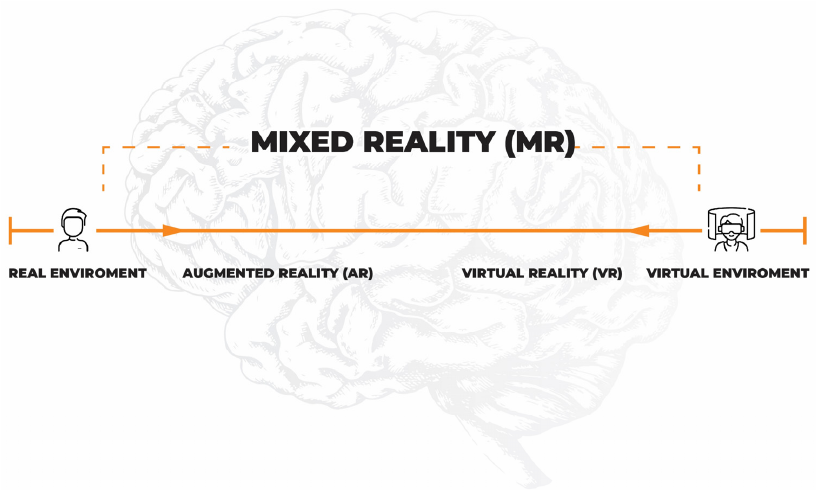
Figure 1. Visualization of immersive interfaces.